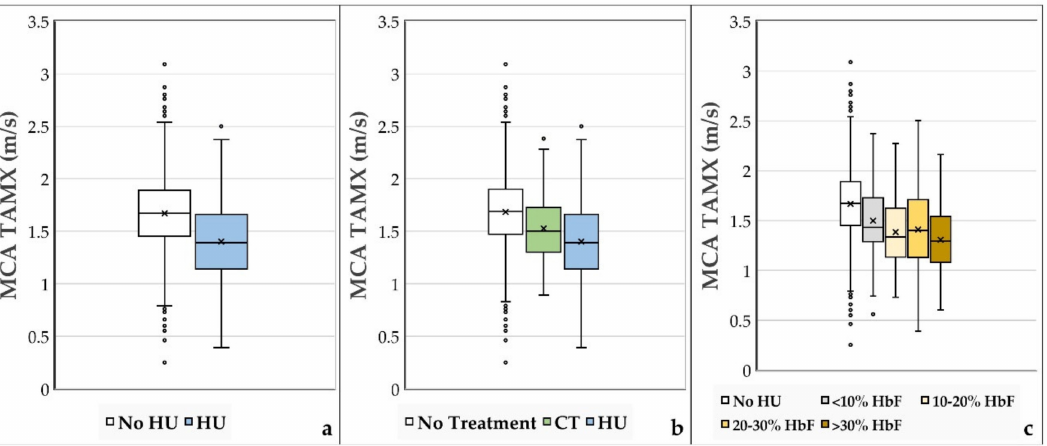
Figure 2. ( a – c ): MCA TAMX Values. Figure 2a,b compares the TAMX velocities based on treatment type at the specific time of each TCD. ( a ) No HU vs. HU at the time of TCD; ( b ) no treatment vs. CT vs. HU received at the time of TCD; ( c ) TAMX values compared by Hemoglobin F (% of total